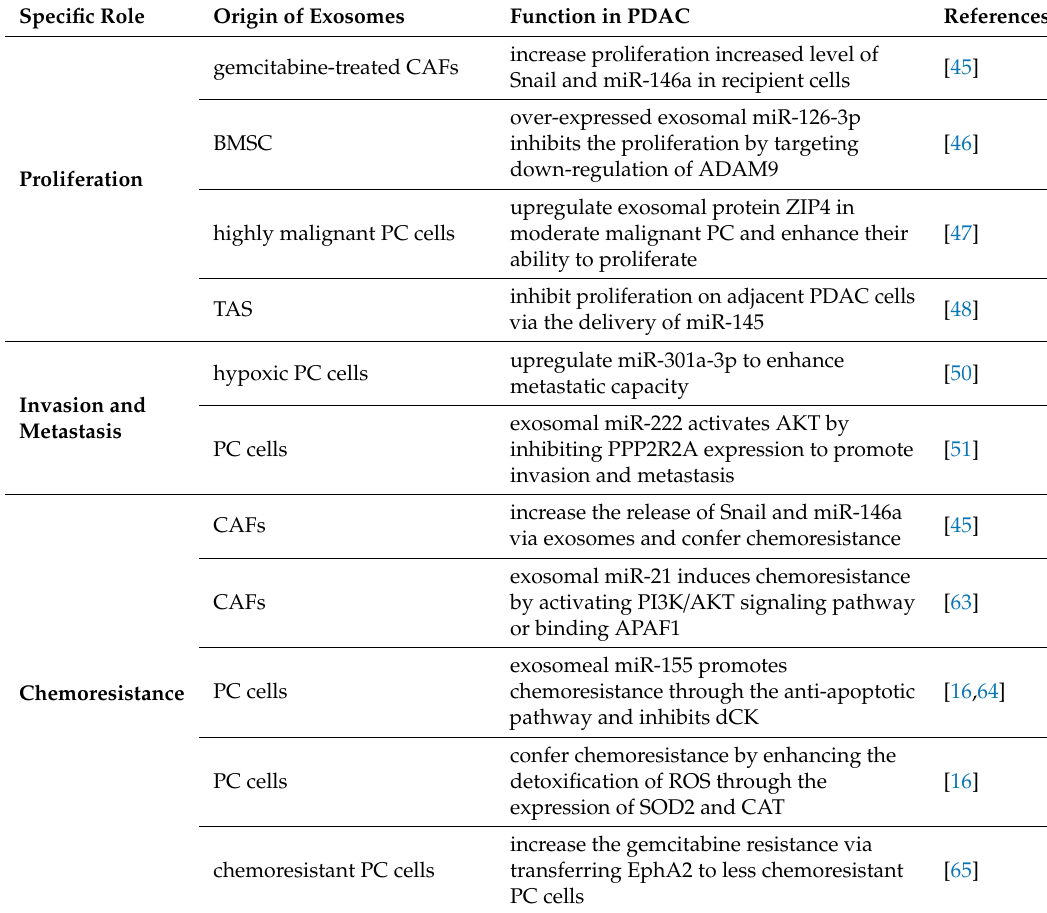
Table 1. Functions of exosomes in pancreatic ductal adenocarcinoma